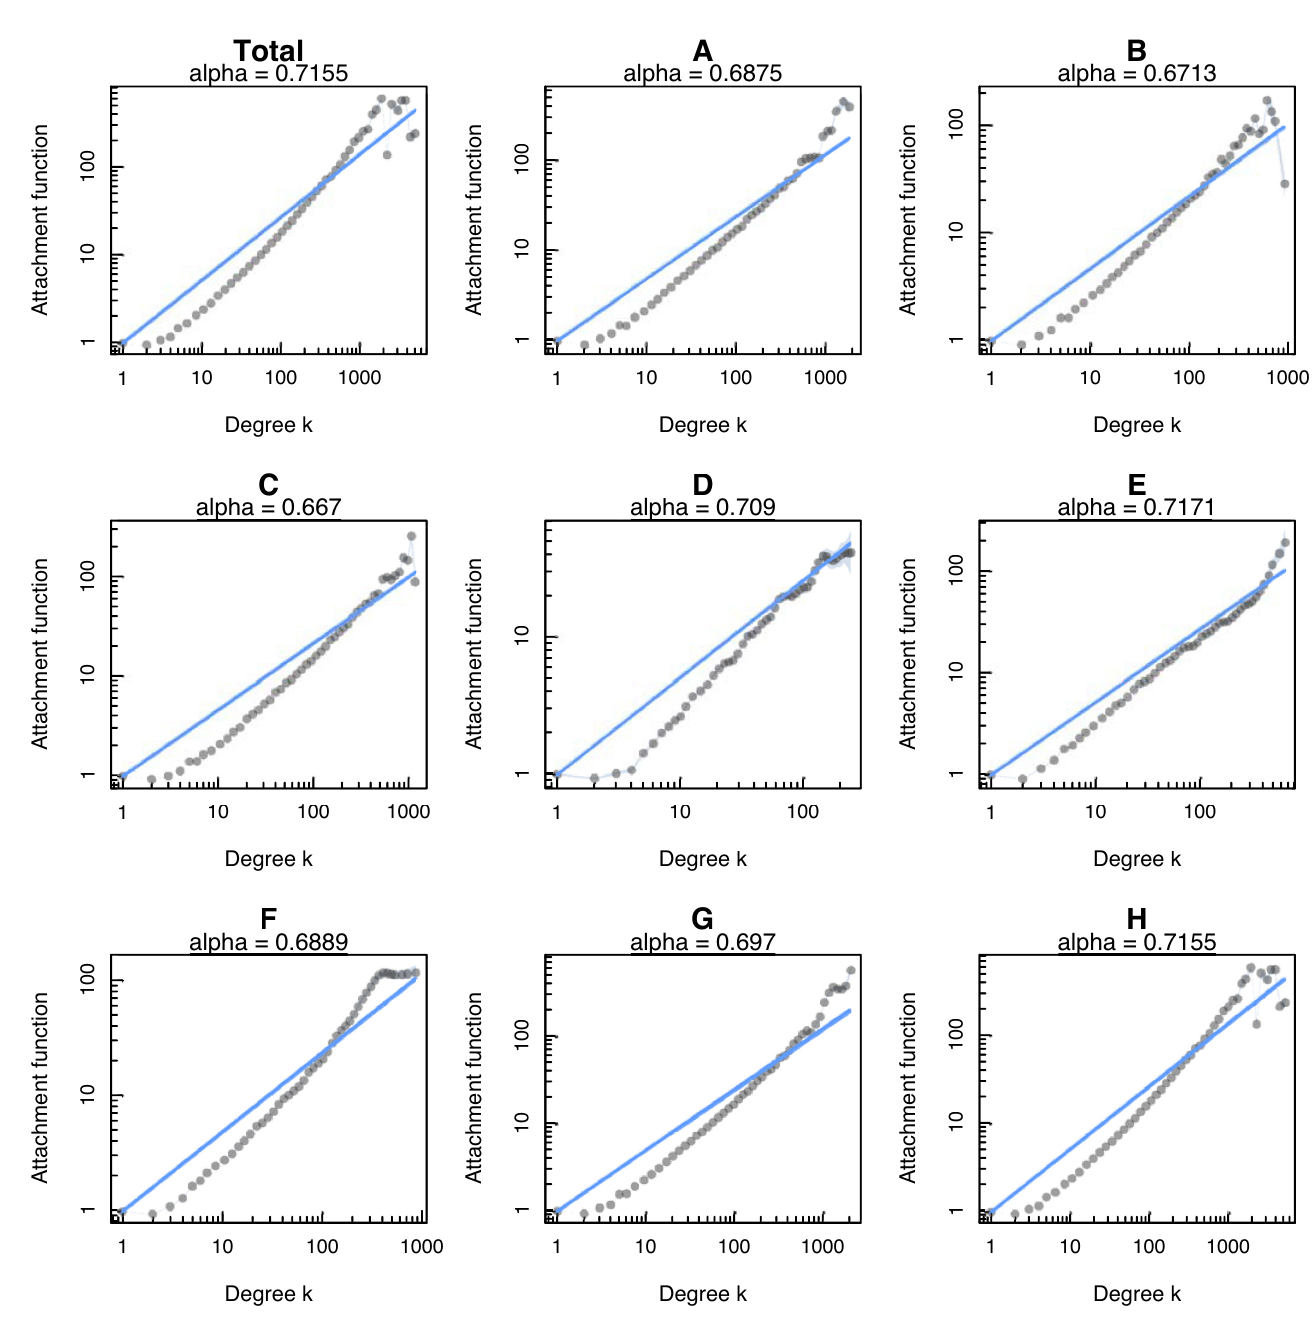
Fig 3. The attachment function and node fitness by technological field using PAFit